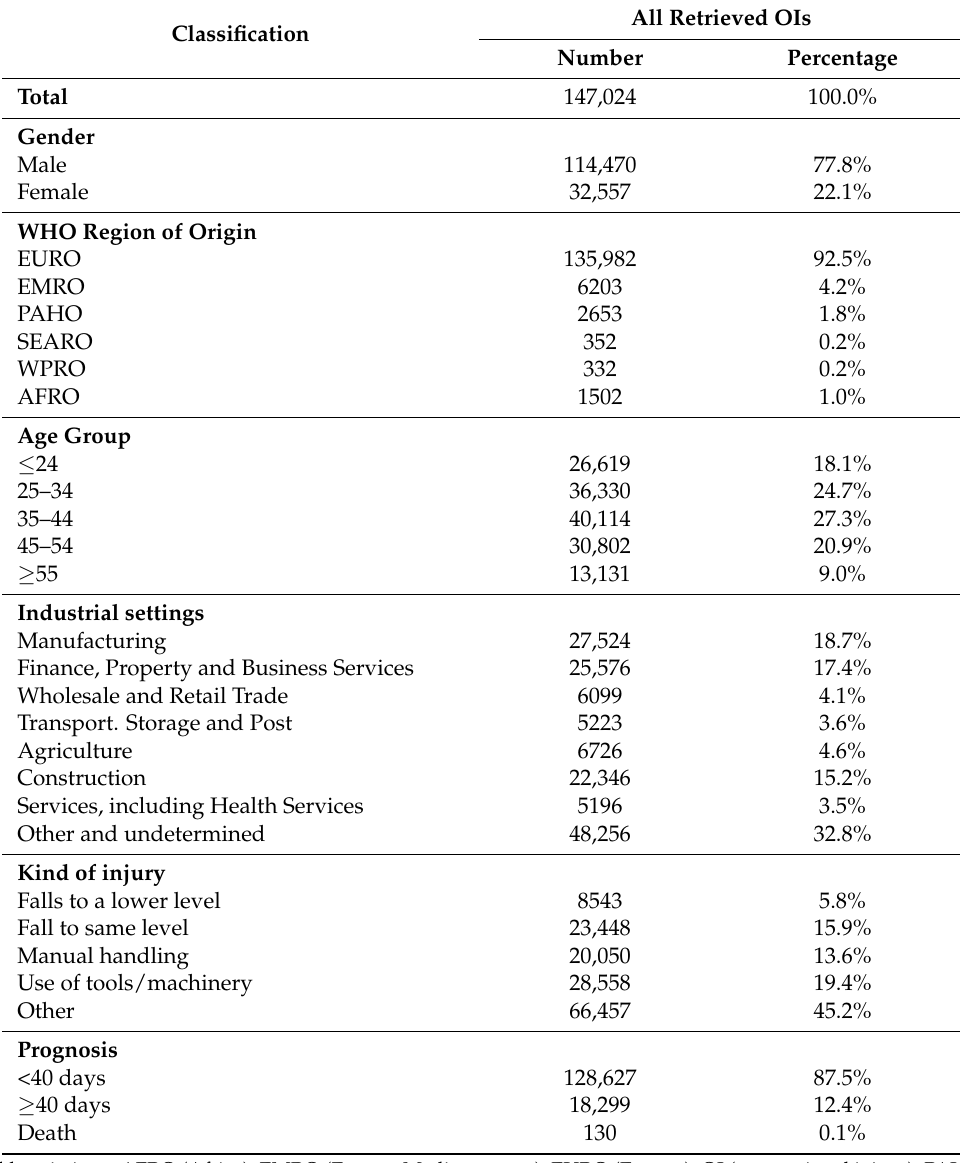
Table 1. Numbers of occupational injuries (OIs) that occurred in the Autonomous Province of Trento (APT) between 2000 and